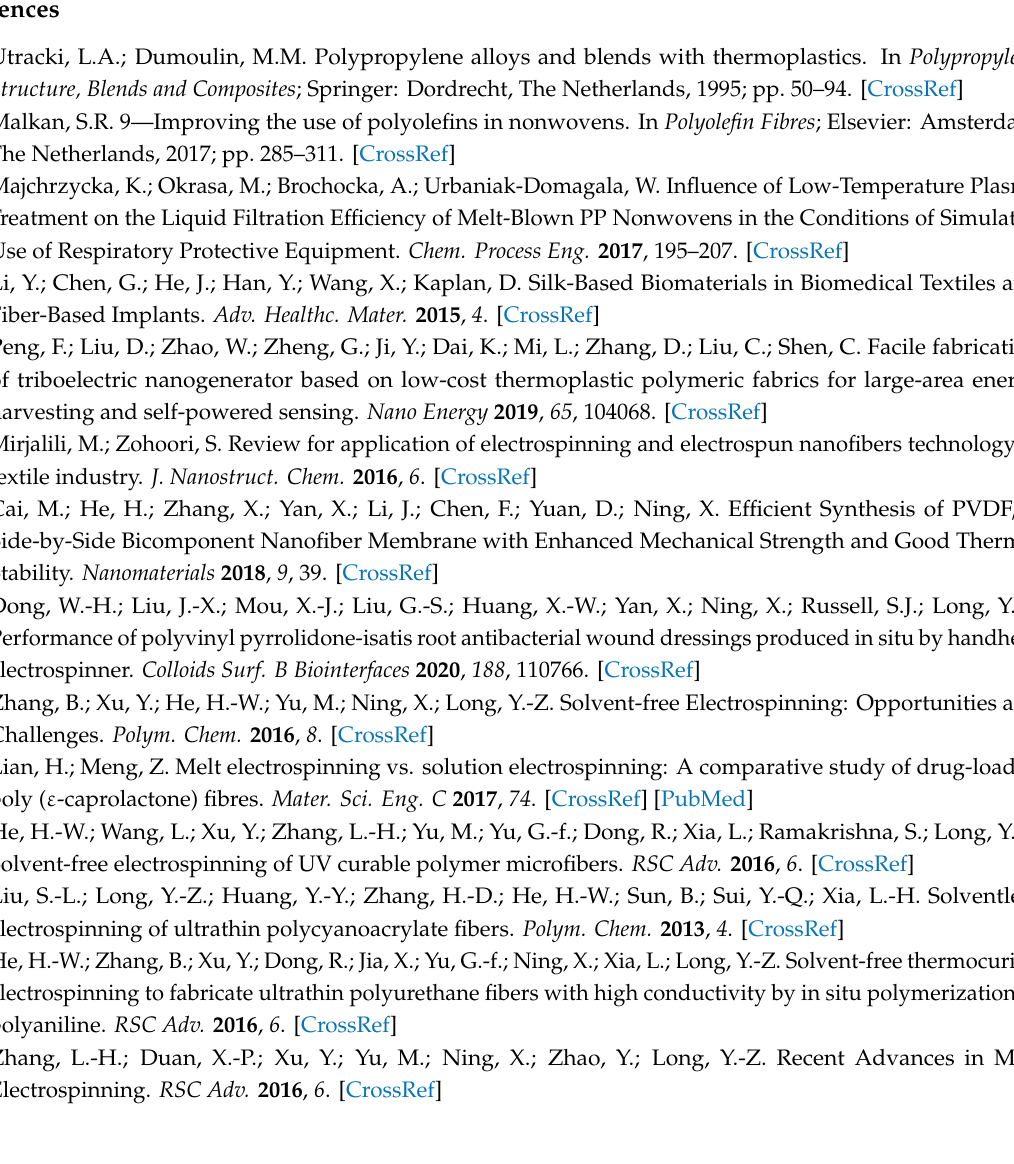
Figure S1: The digital camera photo of pristine PP, nano-ZnO and PP blended with 1wt% ZnO; Figure S2: Stress-strain behaviors of e-spun PP fibers containing